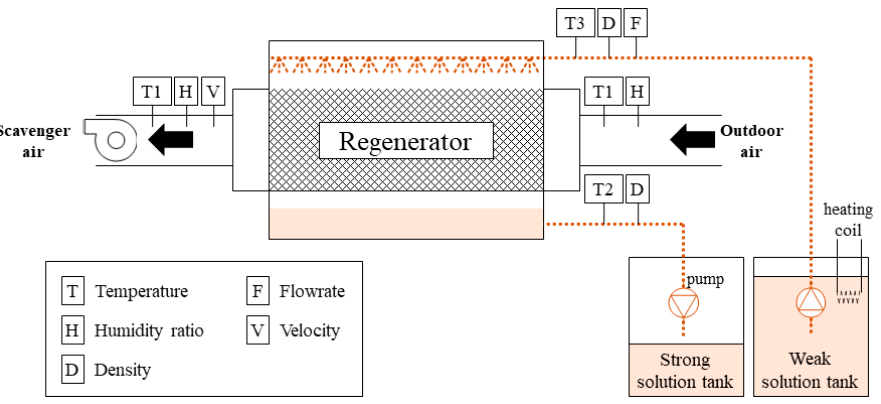
Figure 5. Diagram of the experimental setup and sensor locations.